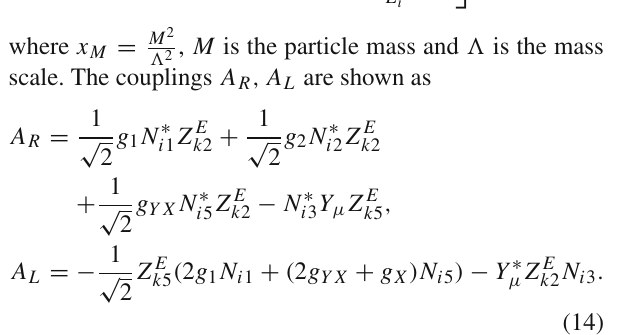
Fig. 2 One-loop Higgs diagrams contributings to muon MDM in the U ( 1 ) X SSM. It is suppressed by the square of the lepton Yukawa cou-